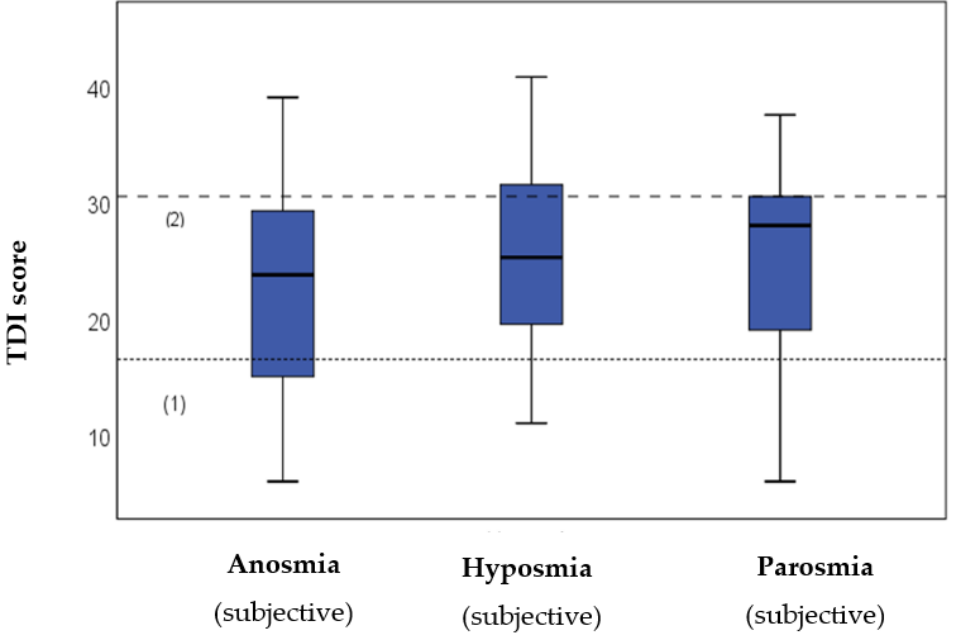
Figure 3. Comparison between TDI scores and subjective categories reported by the patients. (1): Reference line for anosmia (showing 16). (2): Reference line for normosmia (showing 31). The boxes represent the middle 50% of the data and the whiskers the upper and lower 25%. The black line inside the boxes represents the median value. Differences were analysed using the Mann–Whitney U test ( p < 0.05 *). TDI = Threshold, Discrimination, Identification. Table 3. Correlation analyses between the TDI and QOD results. Spearman’s and Pearson’s corre- lation tests were used to detect a nonlinear and linear correlation, respectively. A statistically signif- icant correlation was defined with a p -value < 0.05 *. A perfect correlation can be indicated by a rho of 1. The * indicates a statistically significant correlation. QOD= questionnaire of olfactory disorders; TDI = Threshold, Discrimination, Identification.